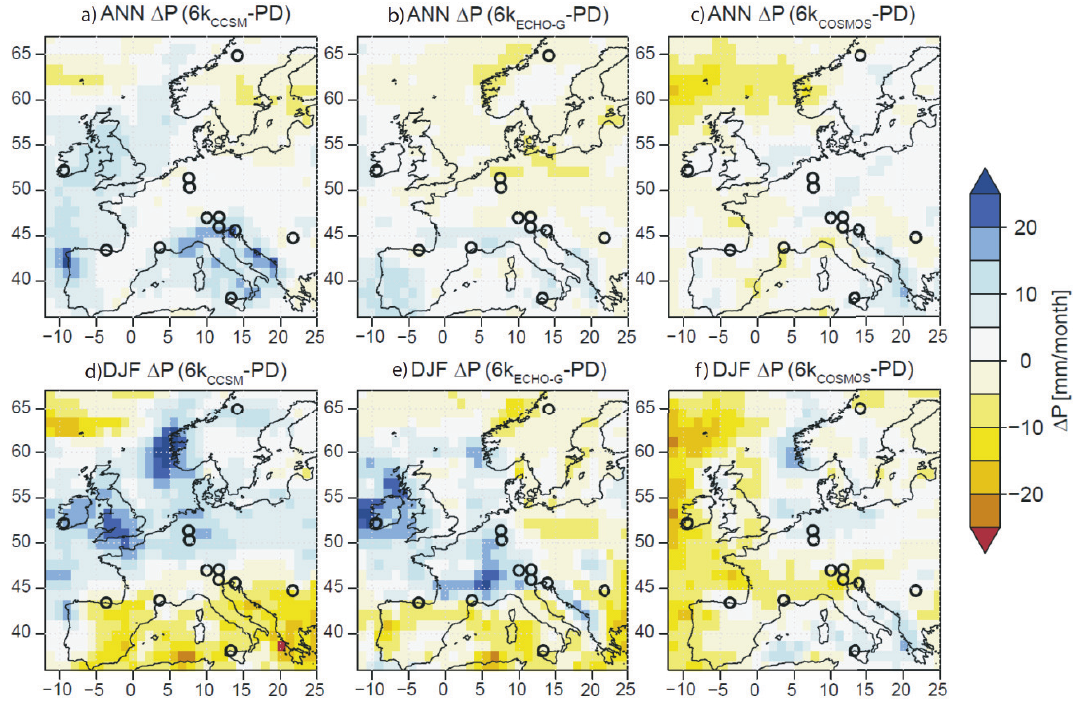
Fig. 4. As Fig. 3, but for precipitation anomalies